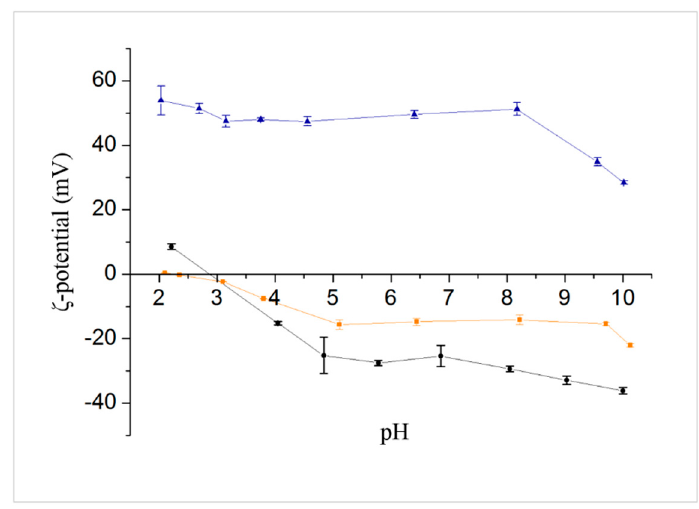
Figure 2. Trend of ζ -potential vs. pH for NRL–medium ammonia (MA) ( ● , - black line), SepS9 ( ■ , - orange line) and SepB5 ( ▲ , - blue line).